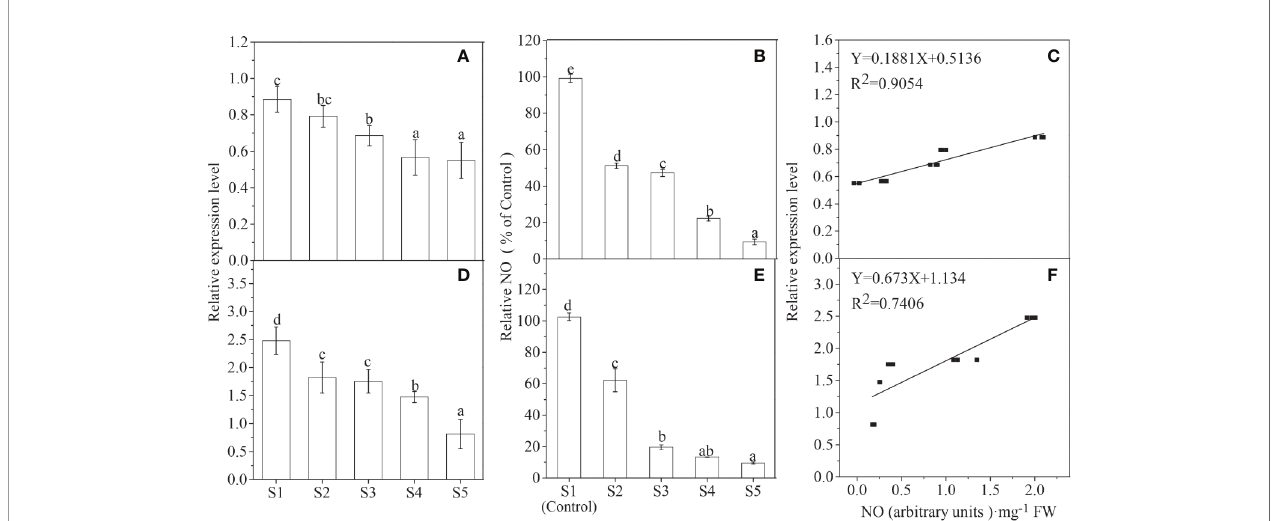
FIGURE 2 | Changes of LbNR gene expression (A, D) and NO release (B, E) as well as their relationship (C, F) during Lycium fruit ripening (p < 0.05). S1 – S5 represents the different developmental stages of Lycium fruits as described in the section of Materials and Methods . The fruit samples were collected at the same time from the same trees that bear fruits at all fi ve developmental stages, and at least three trees of YF (A – C) and BF (D – F) , respectively, were selected. In (B, E) , the NO release was converted to relative values, in which the value of the S1 stage was taken as 100%. The error bars represent the SDs of three independent replicates. Different letters on the bars for the same species indicate signi fi cant differences between the treatments (p < 0.05).